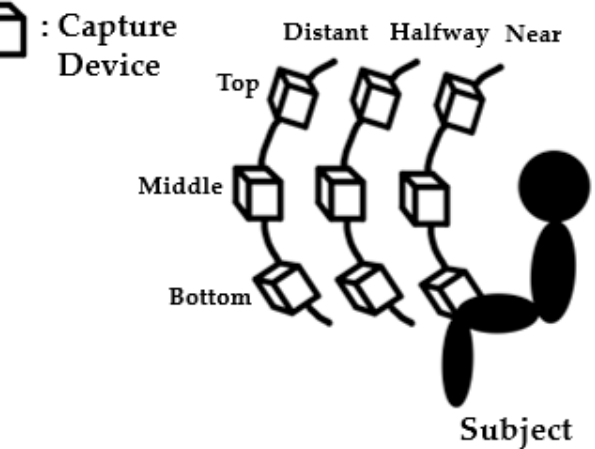
Figure 2. The capturing scheme of PR-FSAD with the three distances and three angles.